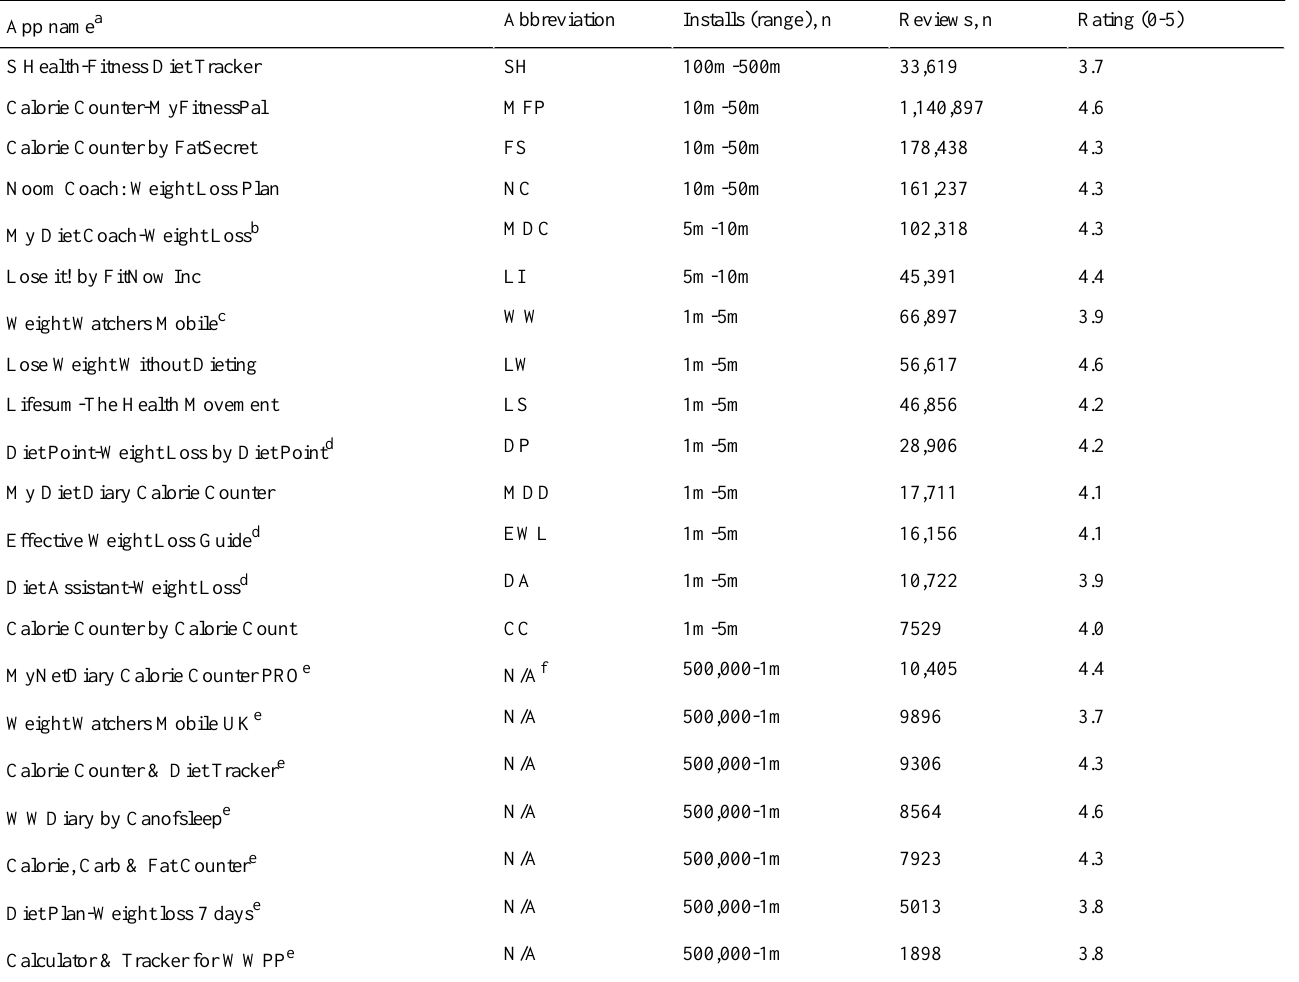
Table 1. Popular (>500,000 installs) nutrition-related apps available in the UK Google Play